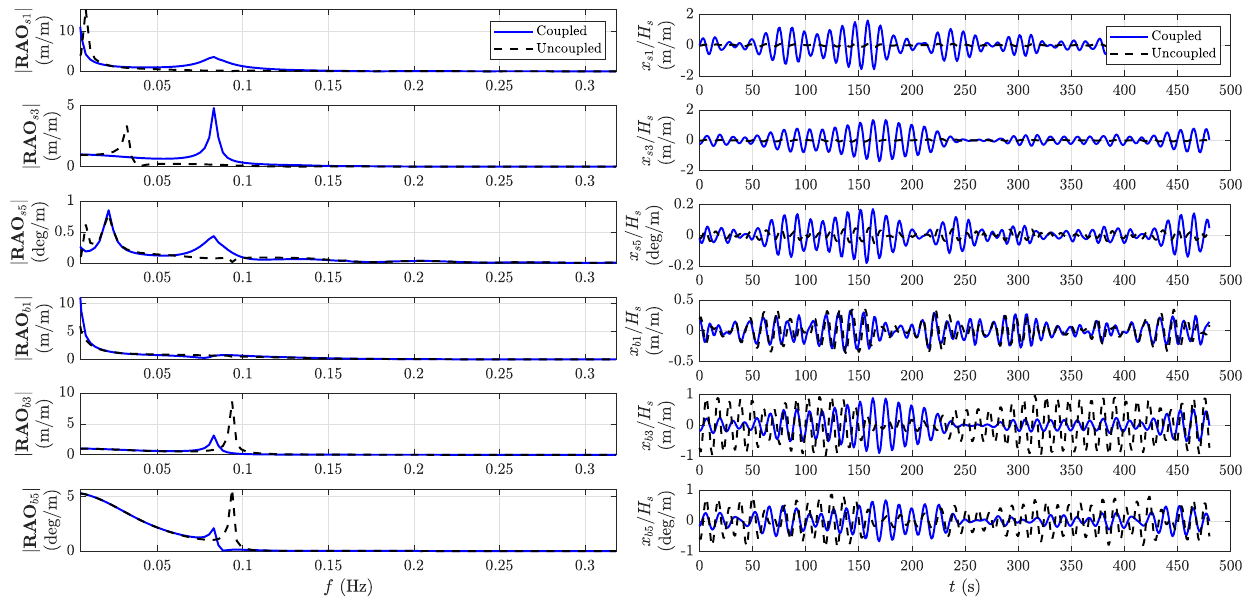
Figure 10. As in Figure 8 but with R BA =